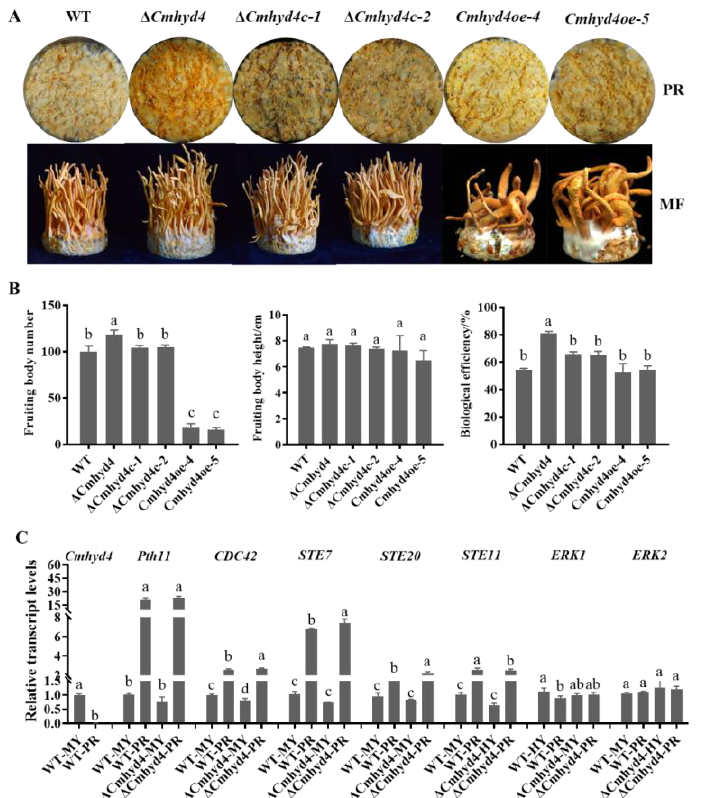
Figure 7. Cmhyd4 negatively regulated fruiting body development in Cordyceps militaris . ( A ) Fruiting body formation and development in WT and mutants—PR: primordium formation (stroma < 1 cm); MF: mature fruiting body. ( B ) Mushroom yield of WT and mutants. After inoculation for 45 d, fruiting bodies were harvested and evaluated. ( C ) The relative transcription levels of Cmhyd4 and fruiting-body-development-related genes at the primordial stage. Error bars represent the SD of three biological replicates with three technical replicates. The different letters over the histogram represent significant differences at p < 0.05.